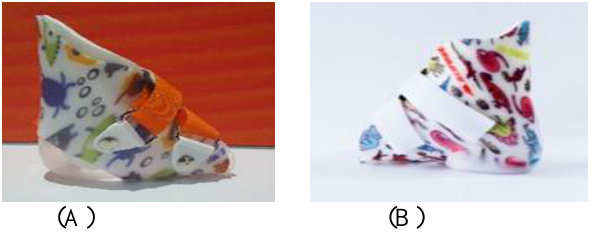
Figure 2. (A) Open Heel modification and (B) Standard Heel Post design 4 .